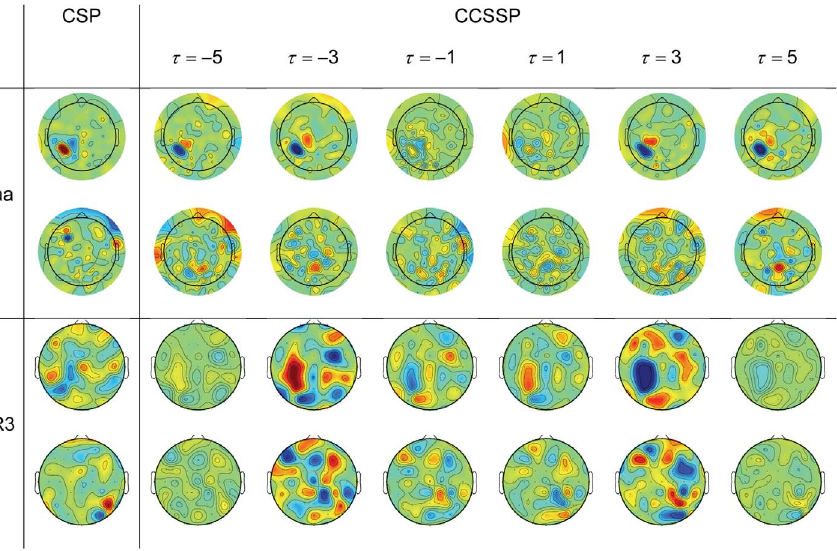
Figure 2. CSP filters and CCSSP spatial-FIR filters for Subject aa and R3. Spatial-FIR filters can be separated into a number of spatial filters, each of which corresponds to a t time-point delayed EEG data. The colourbar ranges from 2 0.5 to 0.5.